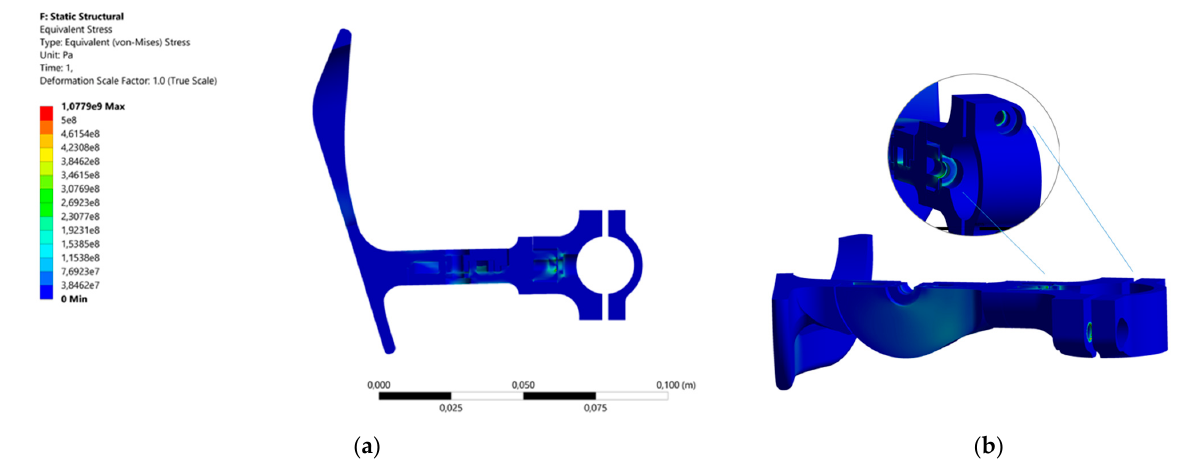
Figure 14. Representation of the results obtained with the finite element model: ( a ) Von Mises equivalent stress distribution; ( b ) Von Mises stress distribution with hotspot details due to geometric discontinuities of the model.